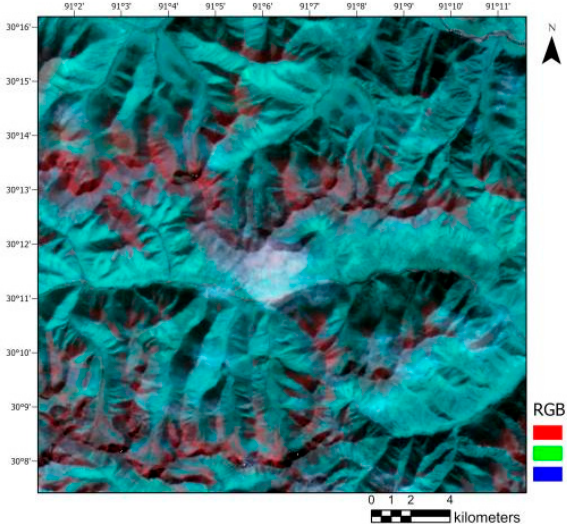
Figure 7. Spectral information in the aluminum hydroxyl-enhanced band.